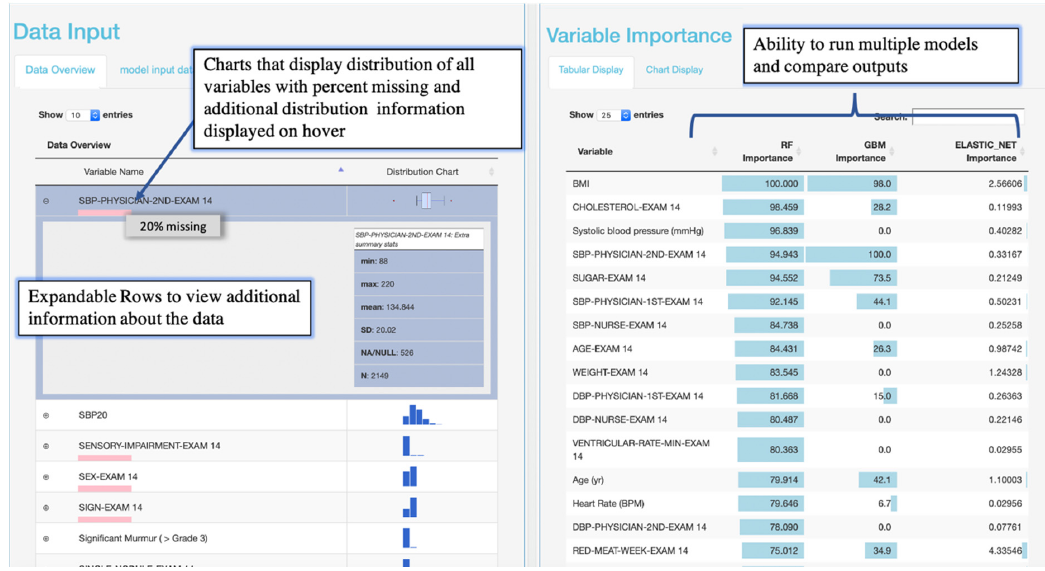
Figure 5. Results from case study 2. Tabular views of the data with expandable rows to obtain additional information relating to variables in the data and variables with a given importance from machine learning output (left). Variable importance tabular layout showing importance metrics scaling from 1 to 100 for all variables input into the model. Weekly red meat consumption is in the topmost important among other known